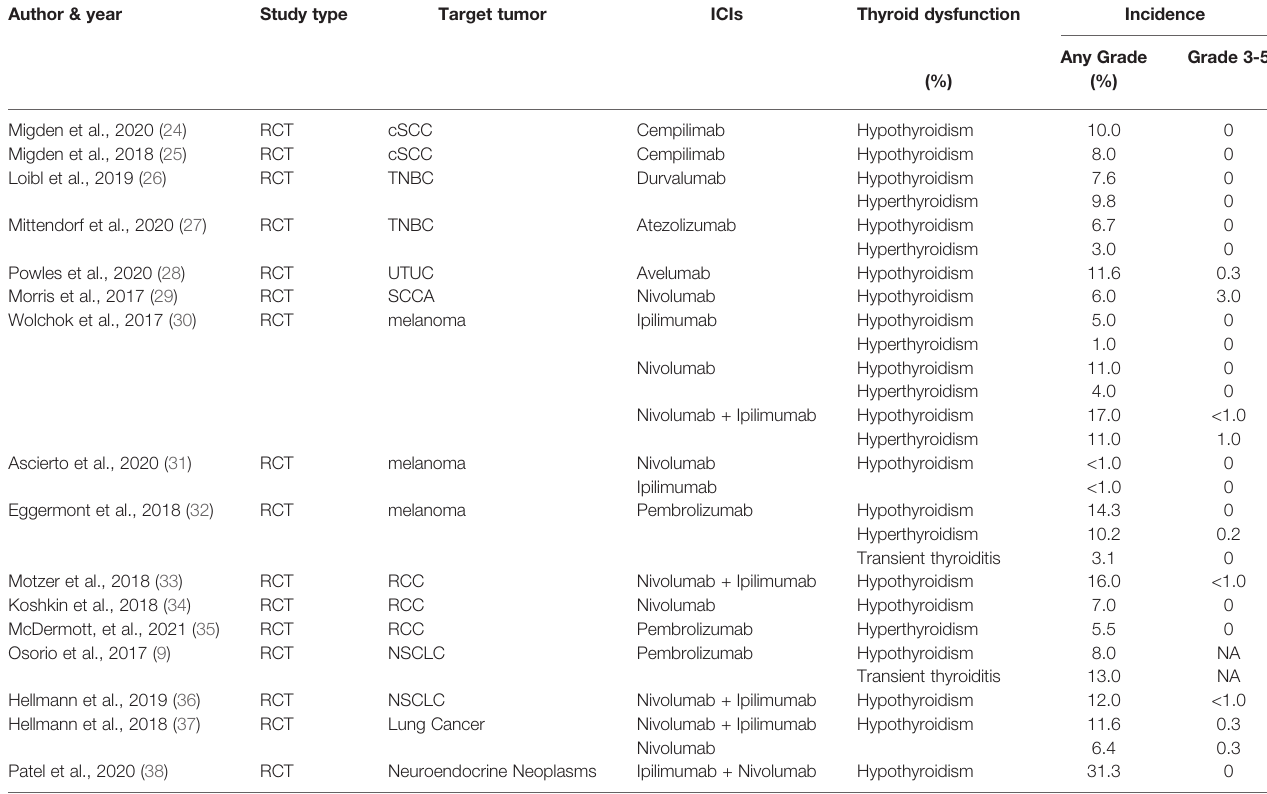
TABLE 1 | Comparison of ICIs-related thyroid